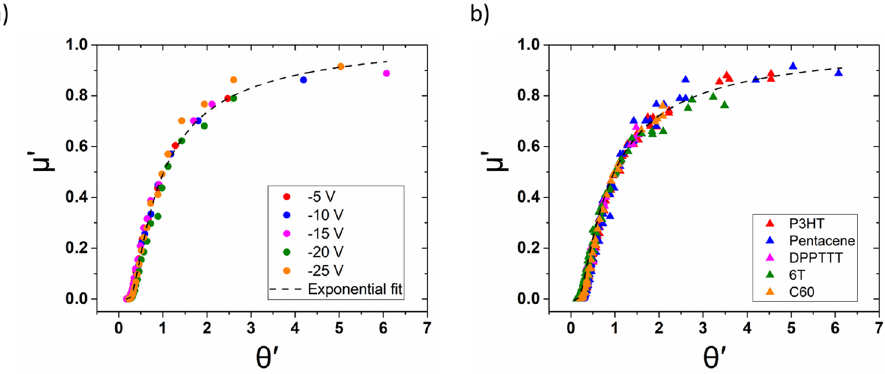
Figure 3. ( a ) Scaled mobility data at different gate voltages (coloured circles) for pentacene OFET and the corresponding exponential curve that fits the scaled data (black dashed line) (data extracted from Ref. 19 ); ( b ) juxtaposition of scaled mobility data at different gate voltages for five different molecules (coloured triangles) resulting in all of them following the same exponential function (shown as black dashed line) as observed in ( a ).